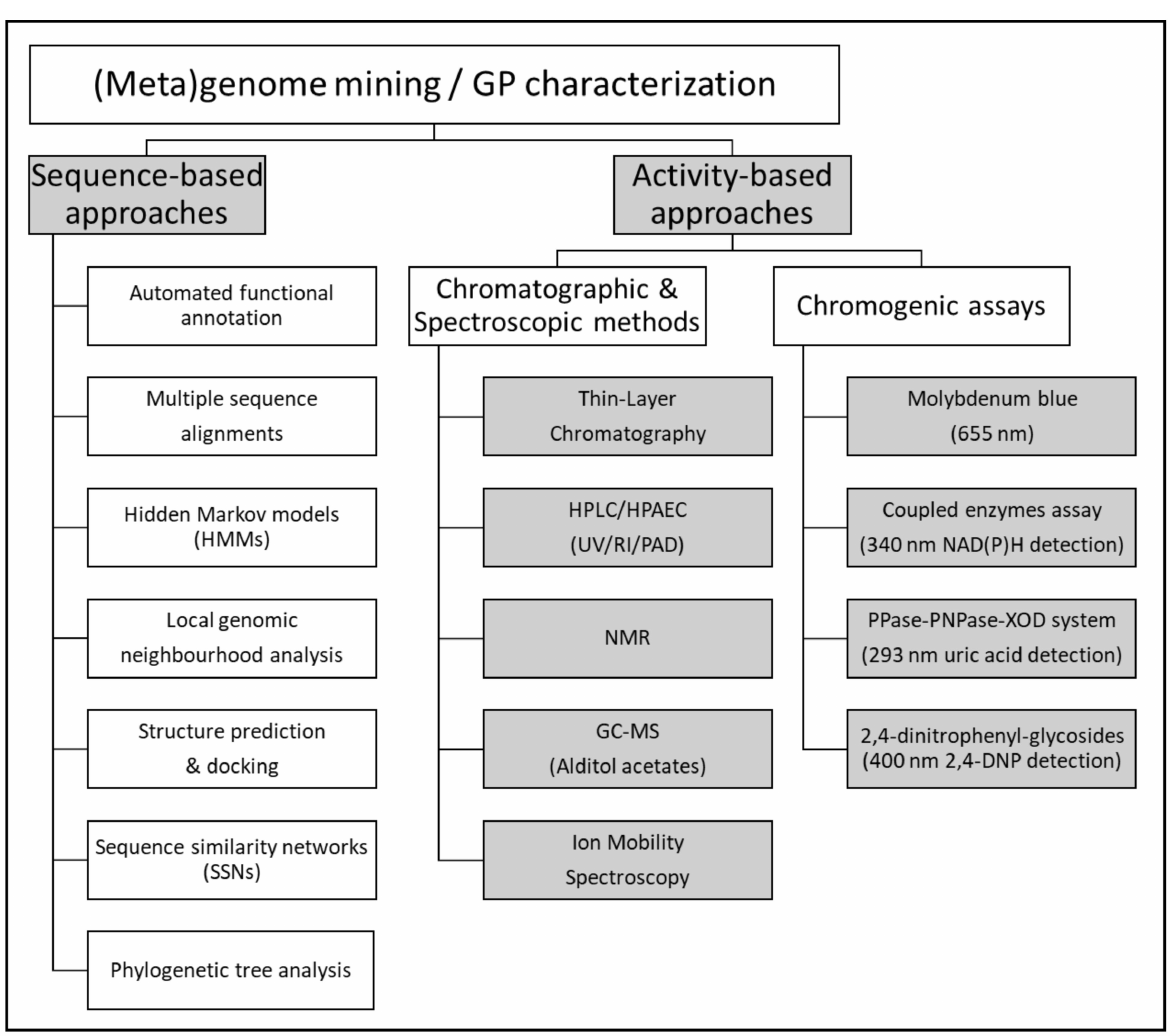
Figure 5. Sequence- and activity-based approaches for GP discovery from (meta)genomes and functional